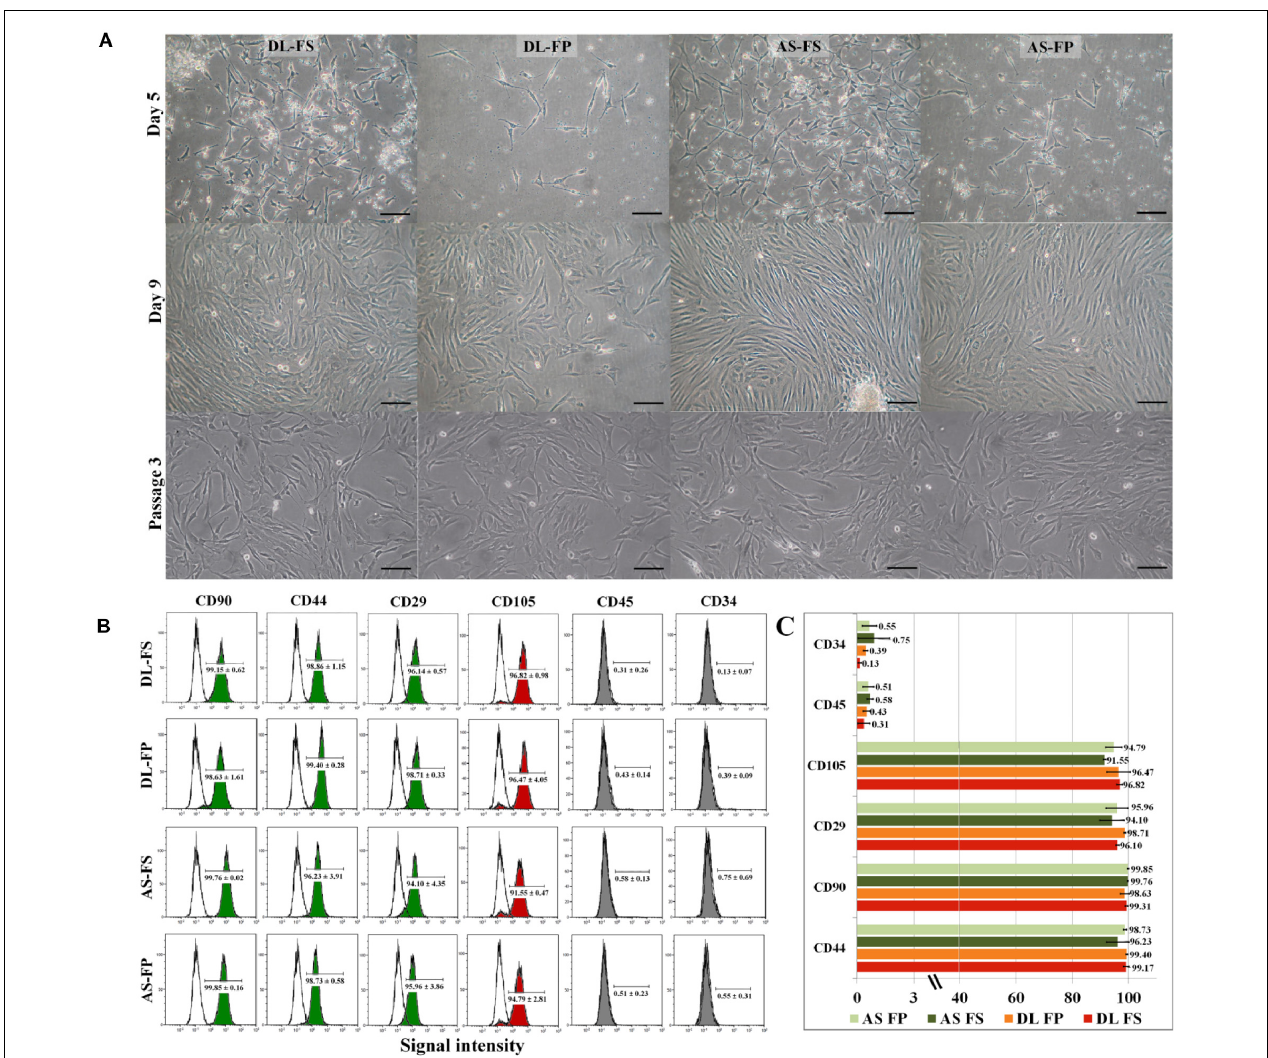
FIGURE 2 | Primary morphology and immunophenotypic profile of the MSCs derived from different synovial tissue sources. (A) The adherent cells from FS in both DL and AS breeds started to attach to the plastic surface on Day 2 of the culture and began to proliferate (for FP, this was clearly seen on Day 5 after plating). The cells showed a spontaneous elongated fibroblastic morphology with vortex-like patterns in the confluent area. The cells reached a sub-confluent state in 9–14 days, although other morphologies, e.g., fat-like cells or epithelial-like cells, were observable in all primary cultures. After passaging the cells, both types of cell became relatively homogeneous and showed similar fibroblast-like morphologies. The FS-SMSCs and FP-SMSCs from both DL and AS breeds showed no morphologic differences under a phase-contrast microscope at Passage 3. Scale bars are 100 µ m, the same scale for all images. (B) Flow-cytometry histograms showing the expression (shaded) of positive cell-surface antigen markers for CD90, CD44, CD29, and CD105 and negative cell-surface antigen markers for CD45 and CD34 molecules for different MSC populations compared with the epitope controls (unshaded peaks), which shared essentially the same surface profile. (C) Comparative analysis of the expression of MSC-related markers of DL-FS, DL-FP, AS-FS, and AS-FP derived cells in red, orange, dark green, and light green, respectively. All analyses were performed on cells that were harvested from three animals of each breed. Values are the mean ± SEM percentage expression of each cell-surface